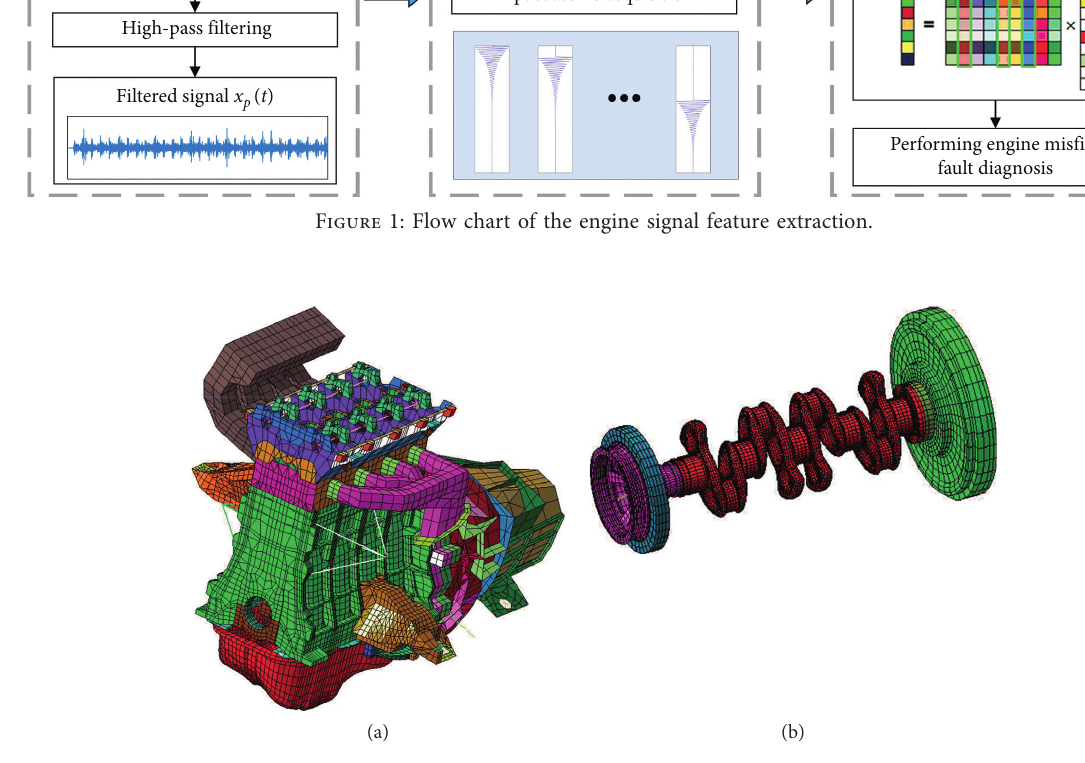
Figure 2: Finite element models. (a) Engine power unit. (b) Crankshaft.